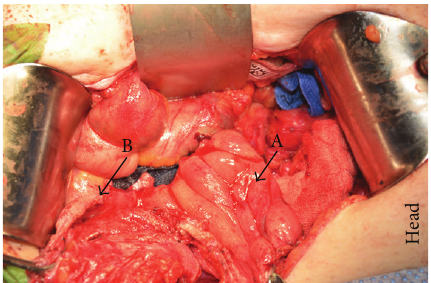
Figure 2: A blind loop of sigmoid colon preserved on native mesenteric blood supply after extirpation of pelvic mass. Sigmoid colon (A) and direction of pelvic defect (B).